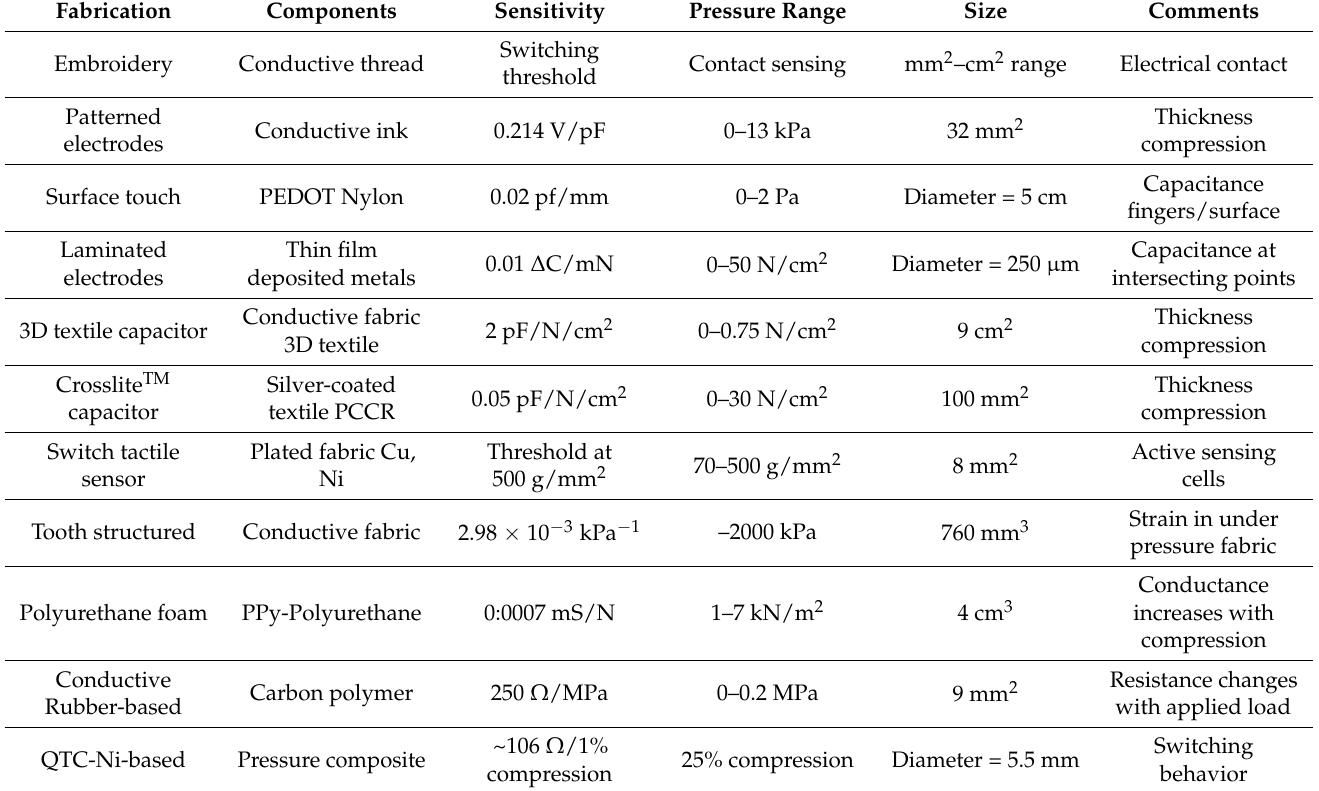
Table 8. A summary of fabric integrated tactile sensors, materials and typical performance data discussed and reviewed by Castano et al. [169].